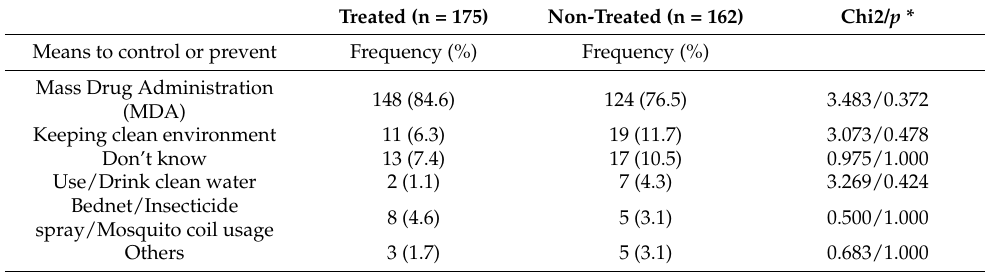
Table 5. Means of control and prevention of LF